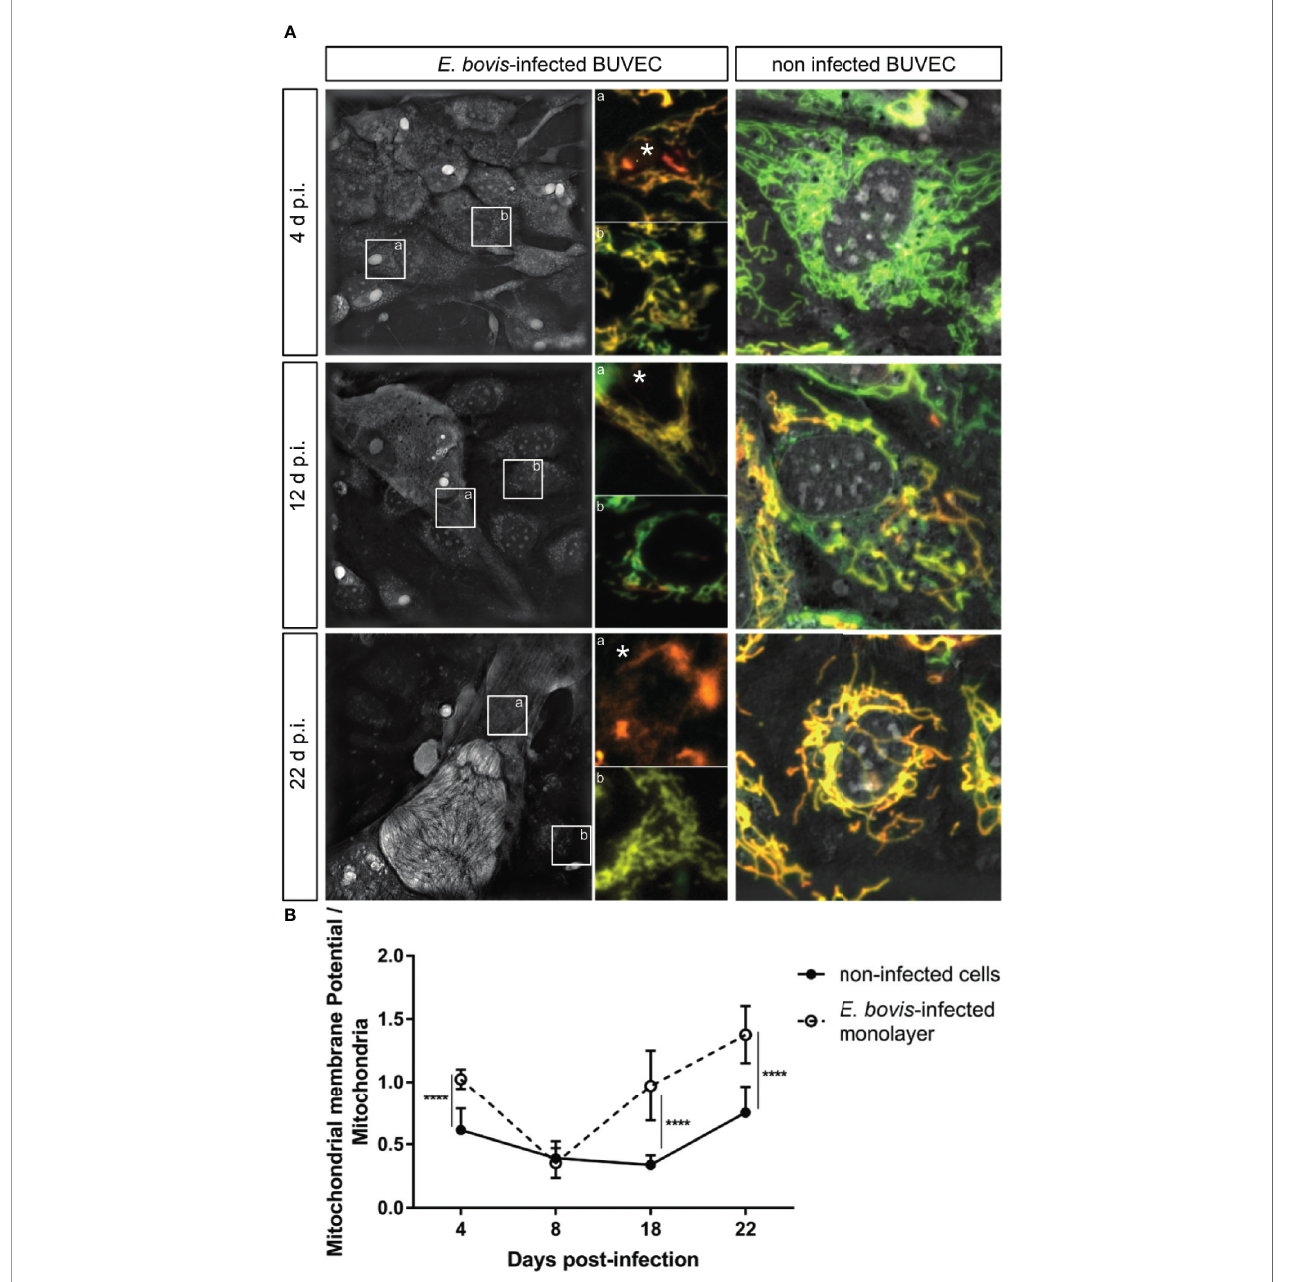
FIGURE 6 | E. bovis -triggered host cellular mitochondrial membrane potential alteration. Mitochondrial membrane potential was evaluated by live-cell imaging using the Image-iT TMRM reagent in non-infected and E. bovis – infected cells. (A) 3D-holotomographic images based on refractive index (RI) were acquired to illustrate the entire mitochondrial network at 4, 12, and 22 days p. i. The insets in the RI image illustrate one infected cell (a) and a non-infected cell (b) within the same monolayer. (a, b) shows the co-localization of total mitochondria (green) with membrane potential (red). The non-infected BUVEC panel shows the co-localization of the 3D-holotomography and the two fl uorescence channels: mitochondria (green) as well as the membrane potential (red) for the non-infected samples. (B) The ratios of total mitochondrial: mitochondrial membrane potential-related signals were estimated by fl uorescence intensities in both non-infected and E. bovis – infected cells. Asterisks identify the parasite localization in the image. Statistical analysis applied was a two-way ANOVA with repeated measurements de fi ning the time as the matching variable (signi fi cance de fi ned as a ≤ 0.05). Values are expressed as means ± SD of three biological replicates. *p = 0.05, **** p ≤